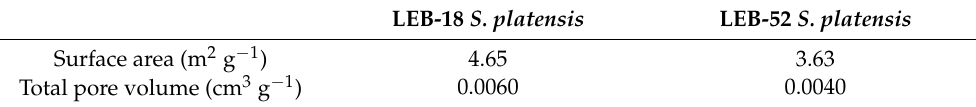
Table 1. Textural properties of LEB-18 S. platensis and LEB-52 S. platensis